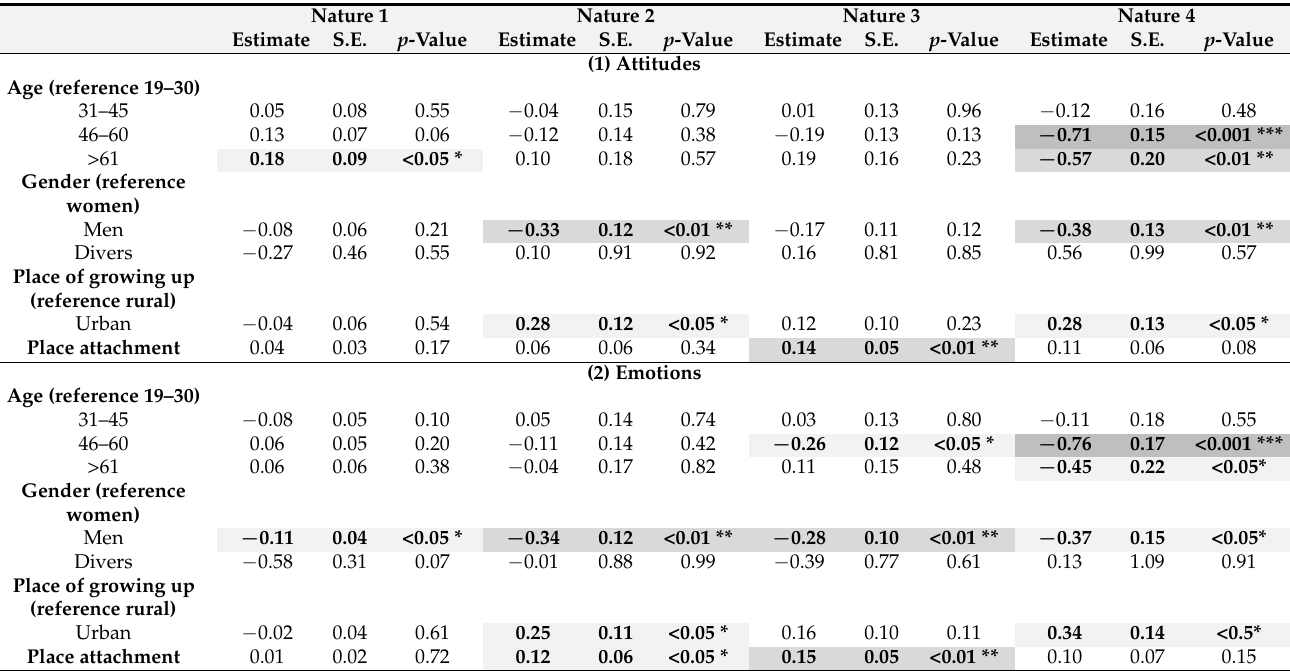
Table 4. Predictive potential of respondents’ socio-demographic background for attitudes and emotions towards the four nature types. Results of the generalized linear models with estimate, standard error (S.E.) and p -value (* p < 0.05; ** p < 0.01; *** p < 0.001). Significant results shown in bold and highlighted in shaded grey. Nature 1 Nature 2 Nature 3 Nature 4 Estimate S.E. p -Value Estimate S.E. p -Value Estimate S.E. p -Value Estimate S.E. p -Value (1) Attitudes